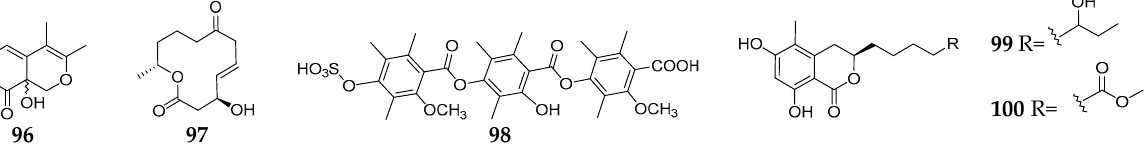
Figure 5. New SMs ( 96 – 100 ) were derived from fungal–fungal co-cultures using PDA.